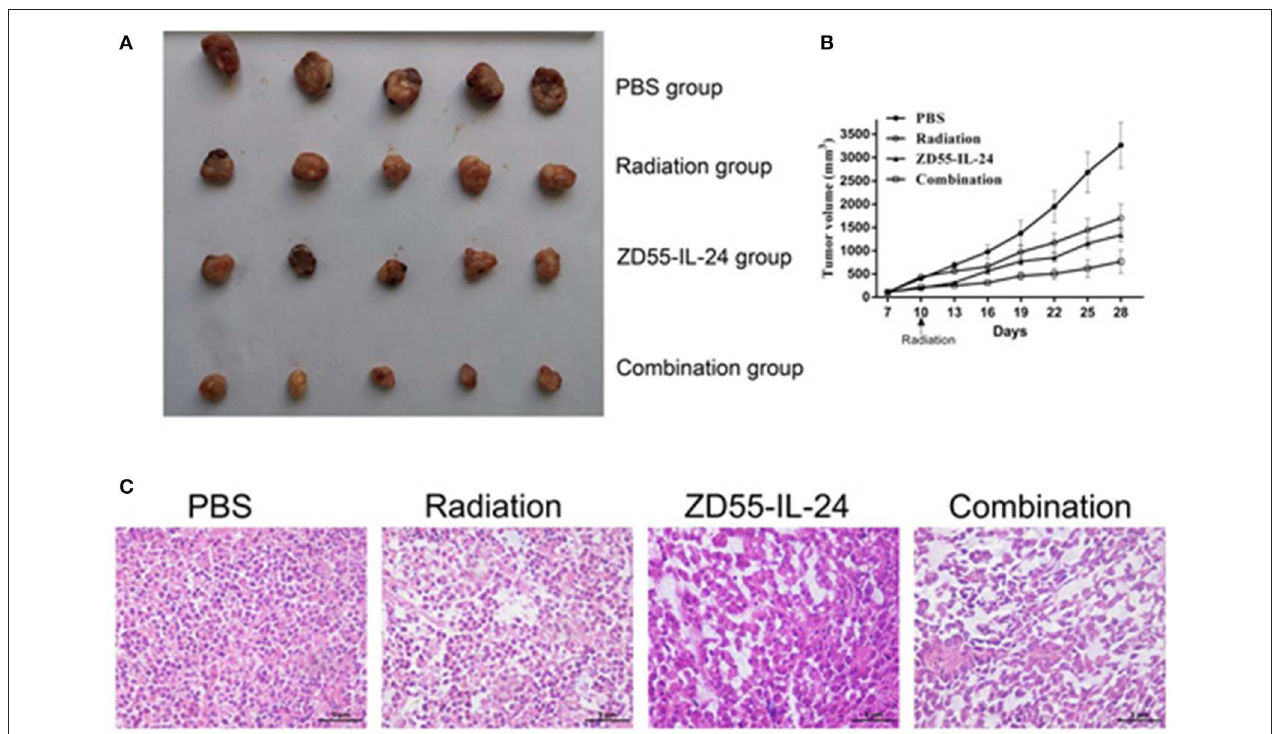
FIGURE 4 | Combination of ZD55-IL-24 and radiation inhibited the growth of xenografts. (A) Prostate tumor xenografts were harvested from each group. (B) Tumor volume was measured at 3-day intervals. Date were expressed as tumor volume ± SD ( n = 5). Tumor growth curves were drawn to show the growth of tumors in each group. (C) HE staining of xenografts of different groups (400 × ). 1, PBS; 2, radiation; 3, ZD55-IL-24; 4, combination of ZD55-IL-24 and radiation.